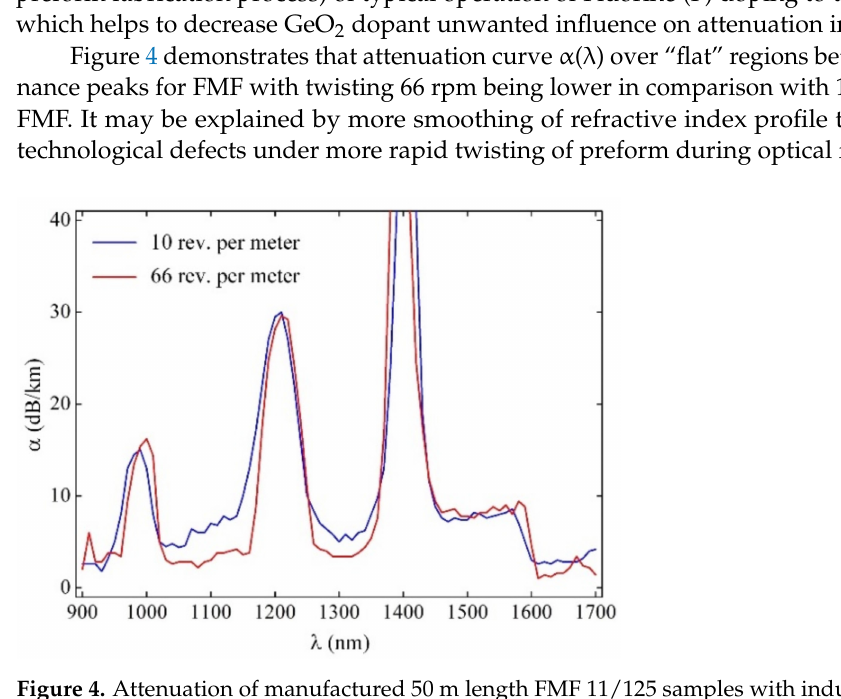
Figure 4. Attenuation of manufactured 50 m length FMF 11/125 samples with induced twisting 10 and 66